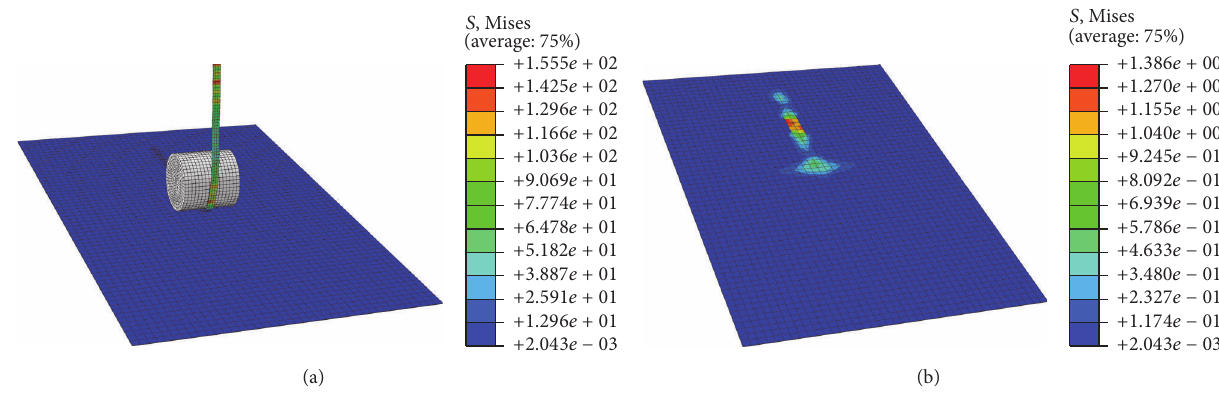
Figure 5: Stress distribution of FEM model with laying speed of 36m/min and compaction force of 150kPa: (a) the entire model; (b) the laminates.